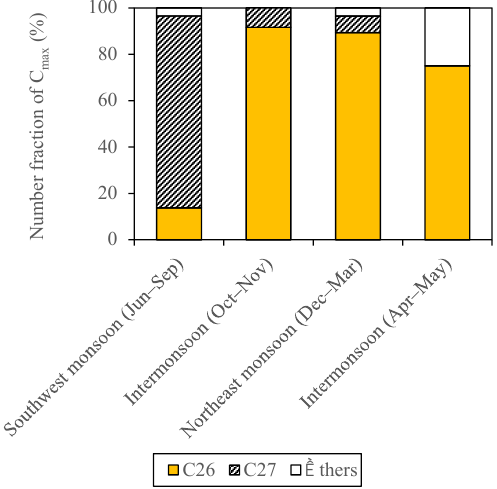
Figure 5. Number fraction of C max in the PM 2 . 5 samples for each monsoon season.